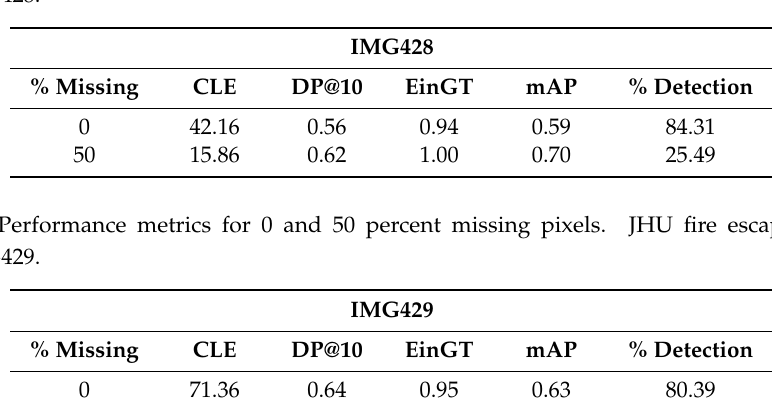
Table 2. Performance metrics for 0 and 50 percent missing pixels. JHU fire escape scenario: Video IMG428.